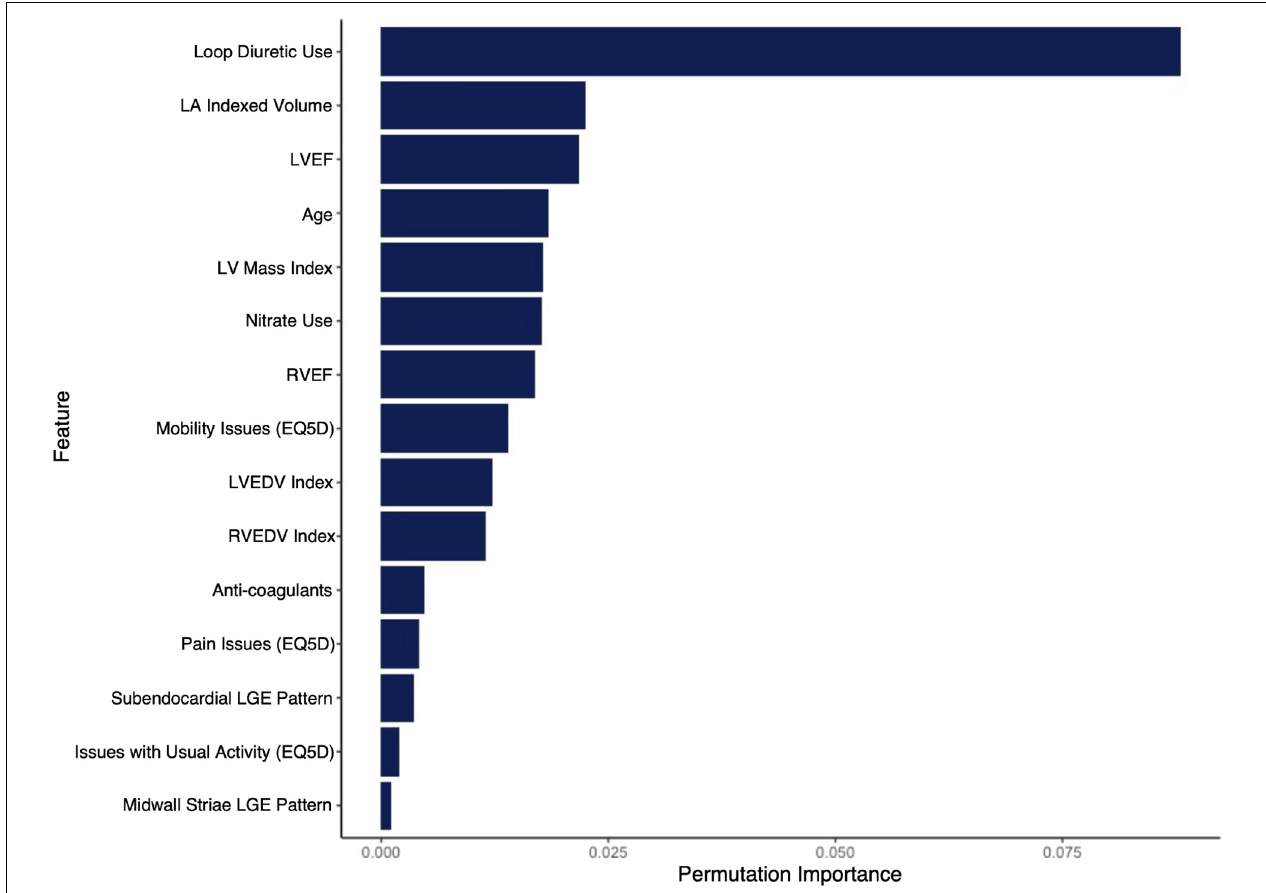
FIGURE 1 | Mean permutation importance values over 100 bootstrap samples for the features included in the final CIROC-HF-RSF model.